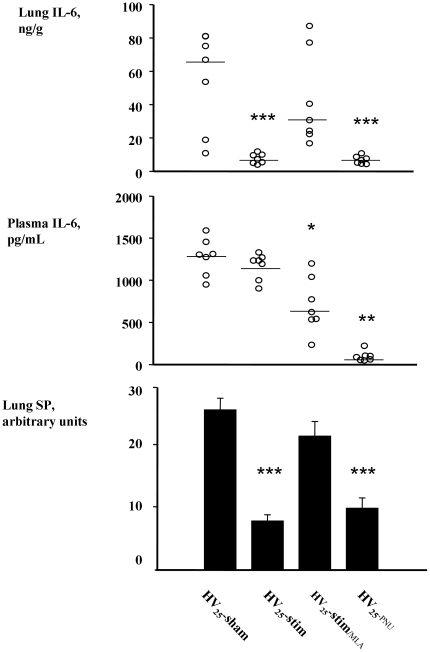
Concentrations of lung and plasma IL-6 and lung substance P contents after high pressure ventilation.IL-6 in lung extracts (top panel) and in plasma (middle panel), measured by ELISA. SP lung contents assessed by HPLC (bottom panel). Individual (circles) and median (horizontal bars) values are indicated for IL-6. SP is presented as mean values (solid bars) and standard error. HV25-sham: injurious ventilation. HV25-stim: injurious ventilation associated with vagal stimulation. HV25-stim/MLA: injurious ventilation associated with vagal stimulation and pre-treatment with the alpha7 nicotinic acetylcholine receptor blocking agent MLA. HV25-PNU: injurious ventilation associated with pre-treatment with the alpha7 nicotinic acetylcholine receptors agonist PNU. Asterisks indicate significant differences versus HV25-sham group (*p<0.05, ** p<0.01; *** p<0.001).